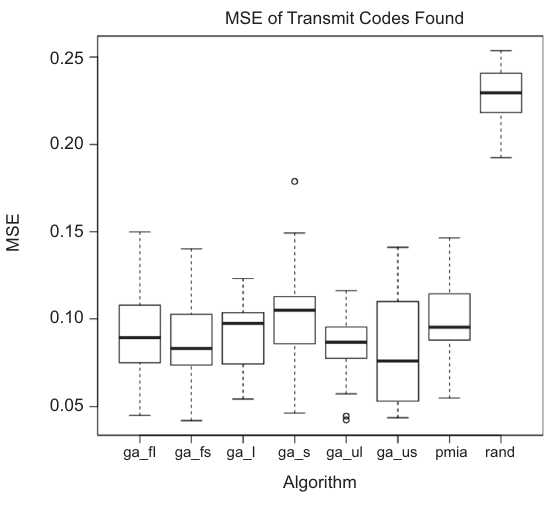
Figure 5. Length 17 64 PSK Box Plot Results.